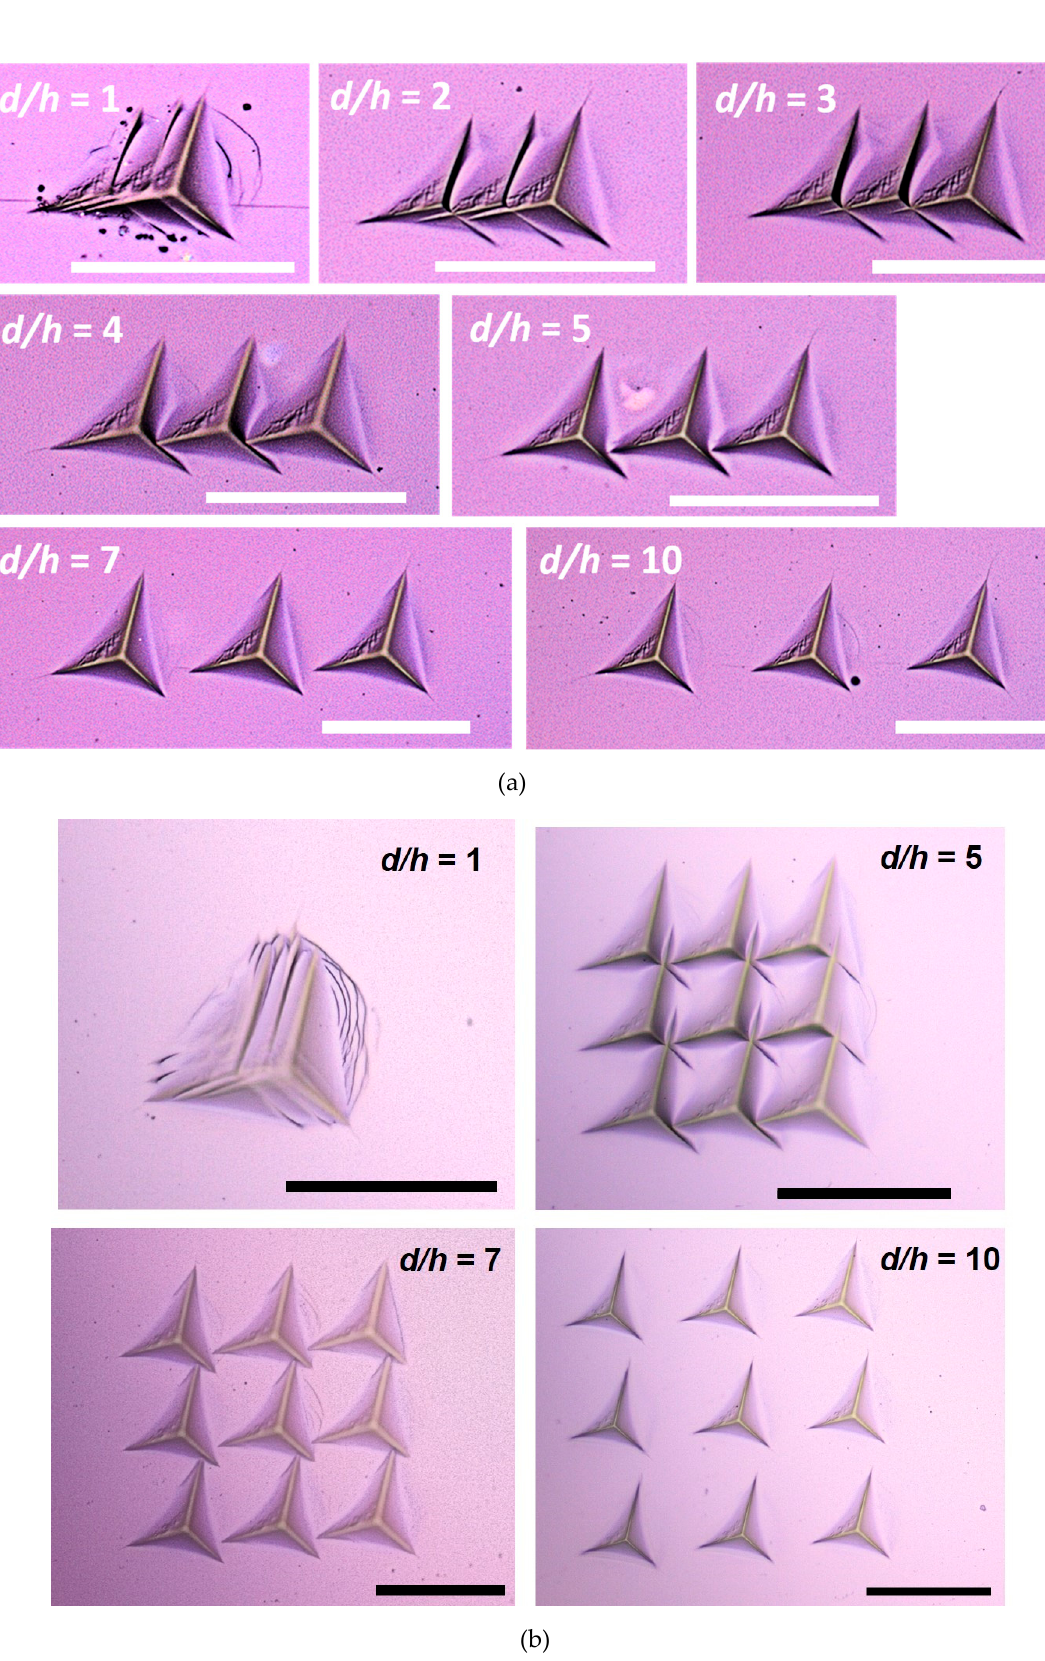
Figure 6. Optical microscope images of Berkovich indentation with h = 5 µm and different spacing ( a ) indents in a single row; ( b ) indents in a 3 × 3 matrix. Scale bar is 50 µm.